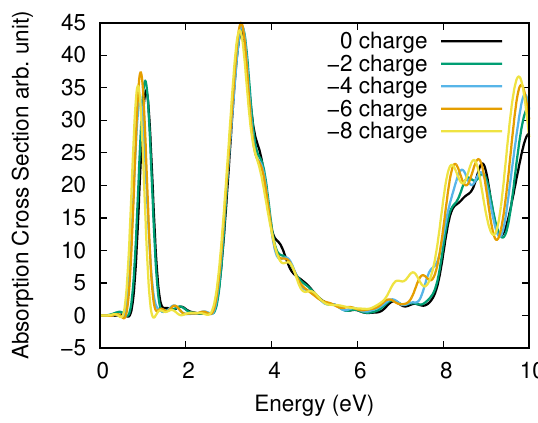
Figure 2. Absorption spectra of a SWCNT when electrons are added to it.